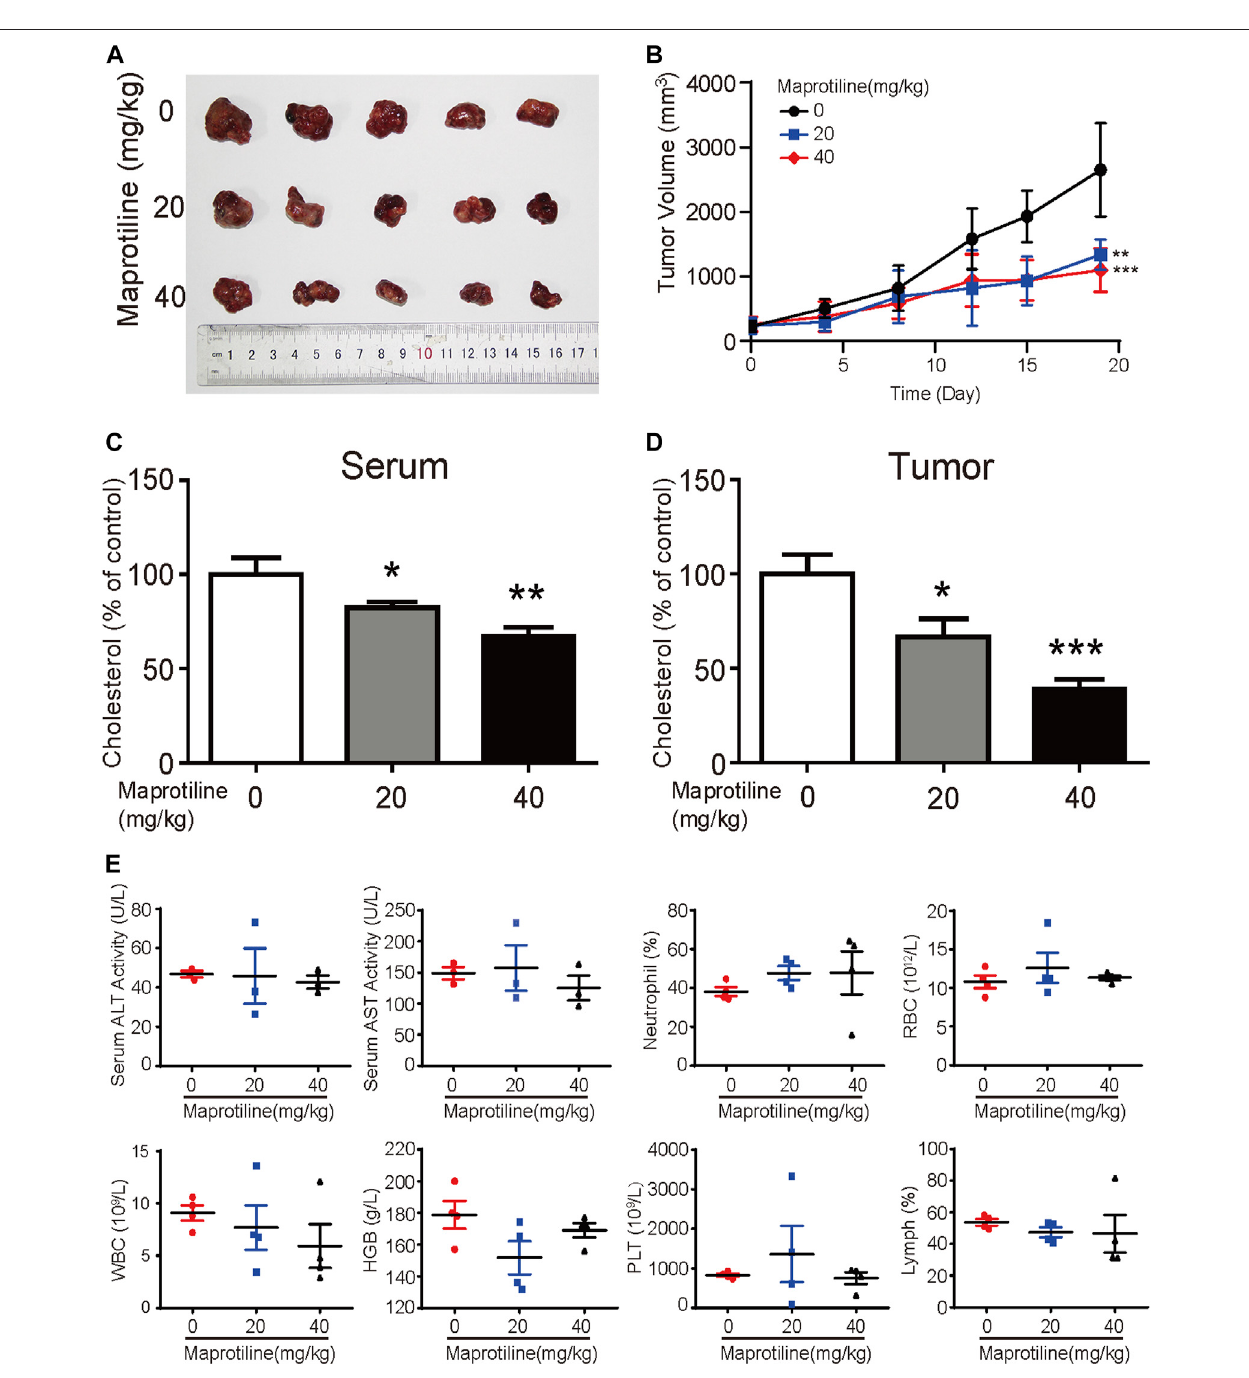
FIGURE6| MaprotilinesuppressesthegrowthofHCCtumorxenografts invivo . (A) Imageoftumorsdisplayingsigni fi cantgrowthinhibitionofHuh7-derivedtumor xenografts( n (cid:2) 5)bymaprotiline. (B) Thetumorgrowthcurveshowsthatmaprotilinesigni fi cantlysuppressedthegrowthoftumorxenografts. (C) Therelativecholesterol level in the serum of the maprotiline-treated nude mice compared with the control mice. (D) The relative cholesterol level in the tumors of the maprotiline-treated nude mice compared with that of the control group. (E) Comparison of serum alanine aminotransferase (ALT) and aspartate aminotransferase (AST) levels between the maprotiline-treated and control groups, as well as red blood cells (RBCs), white blood cells (WBCs), neutrophils, lymphocytes, hemoglobin (HGB) and platelets (PLTs).